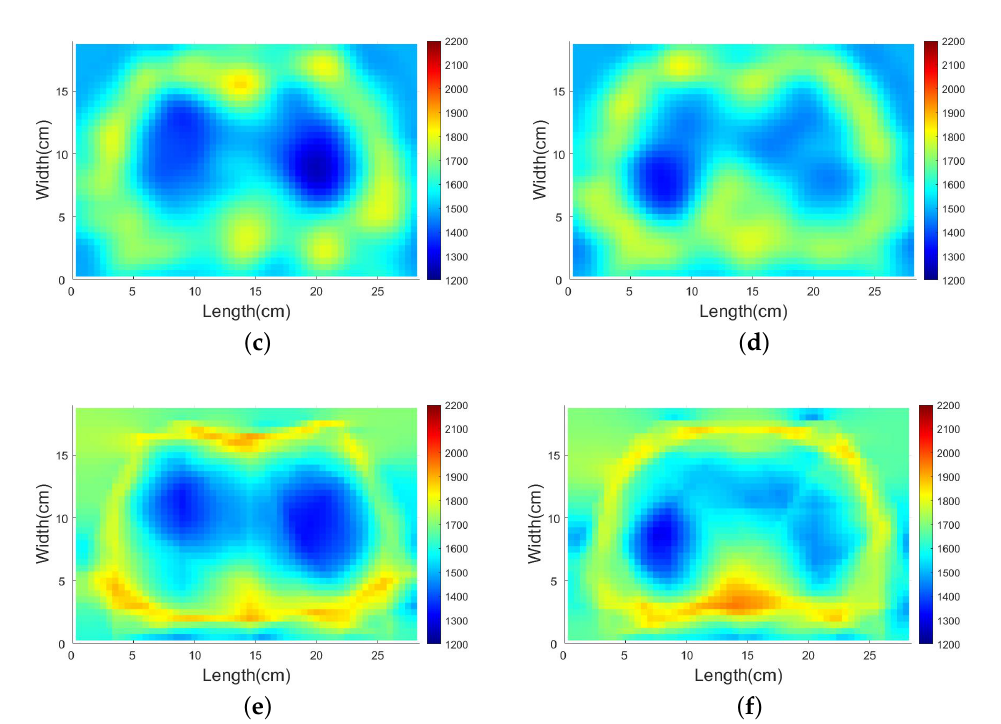
Figure 12. Thorax acoustic velocity distribution of a pleural effusion patient breathing in air and a pneumothorax patient breathing out air and the corresponding reconstruction results. ( a ) Thorax acoustic velocity distribution of a pleural effusion patient when breathing in air. ( b ) Thorax acoustic velocity distribution of a pneumothorax patient when breathing out air. ( c ) SDM inversion result of the thorax model ( a ). ( d ) SDM inversion result of the thorax model ( b ). ( e ) Gauss–Newton inversion result of the thorax model ( a ). ( f ) Gauss–Newton inversion result of the thorax model ( b ). Colorbar: 1200–2200